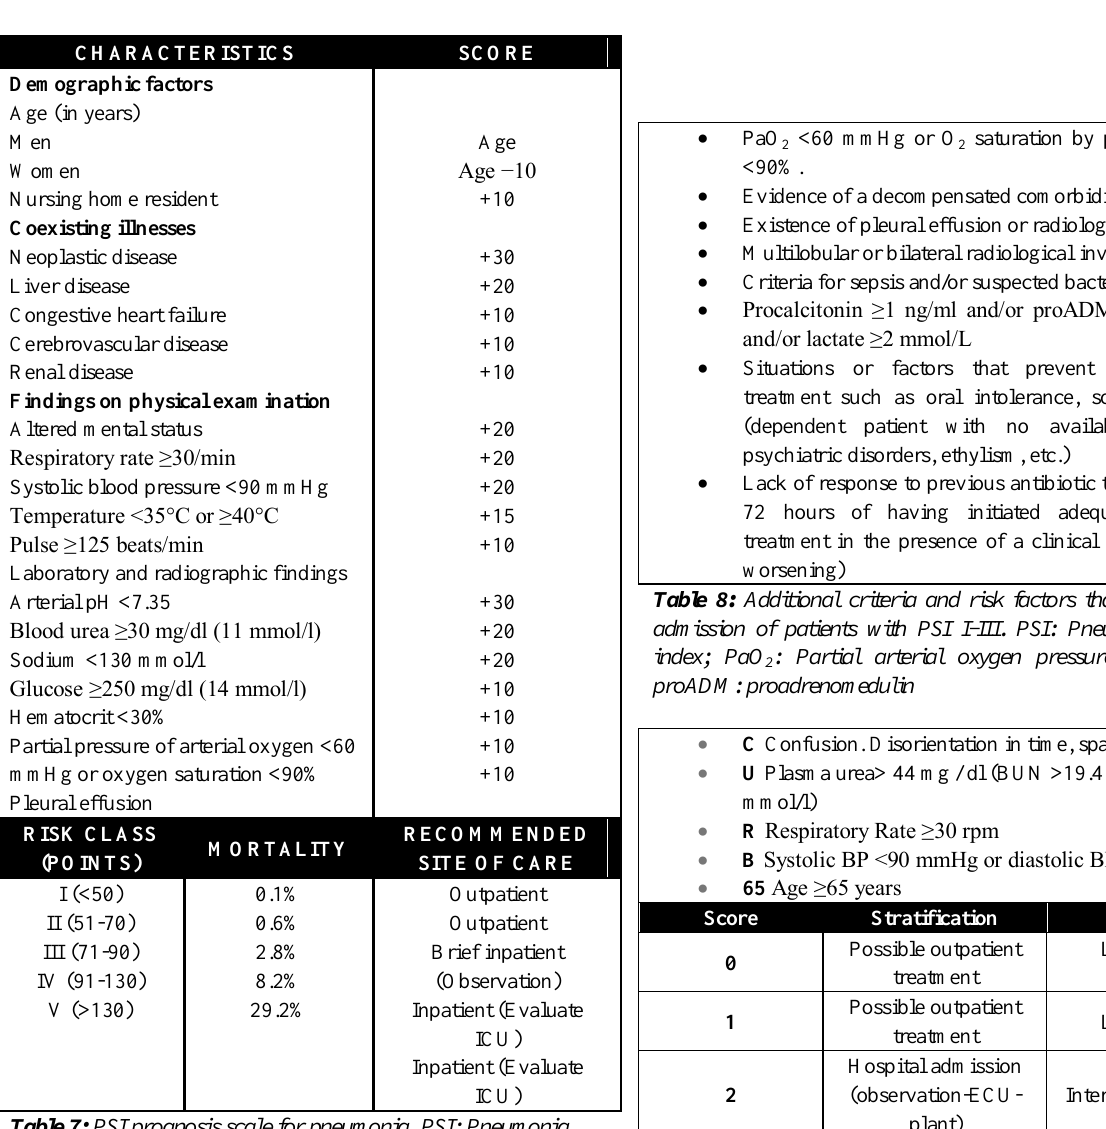
Table 7: PSI prognosis scale for pneumonia. PSI: Pneumonia severity index; ICU: Intensive Care Unit.